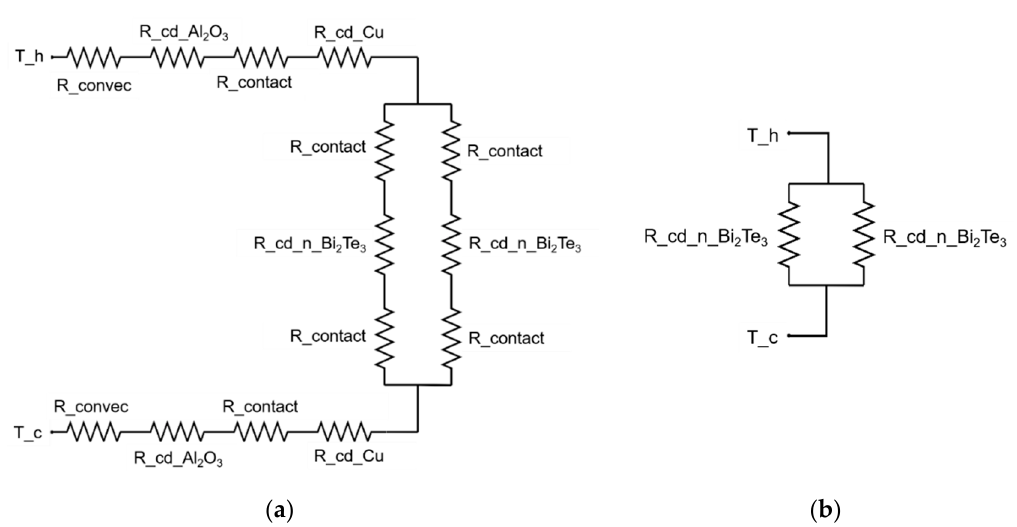
Figure 2. Thermal representation of a thermoelectric pair ( a ) and simplified representation used in the analytical model ( b ). T —hot and cold temperatures; R —resistances of contact, convection, and conduction.